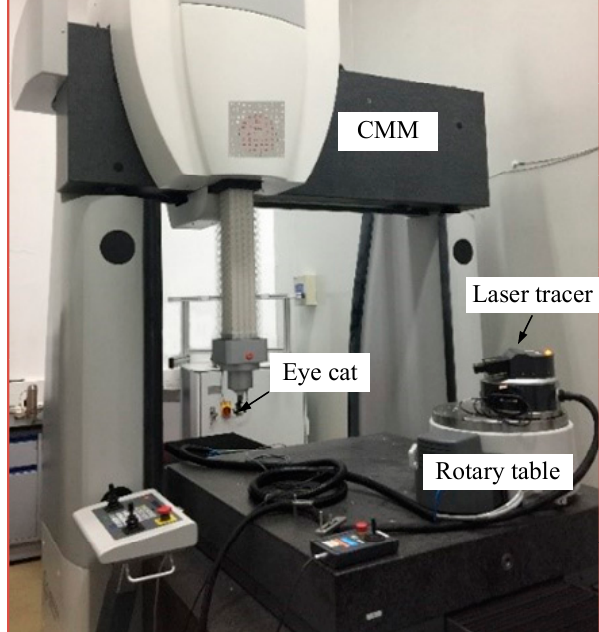
Figure 5. Experimental platform.